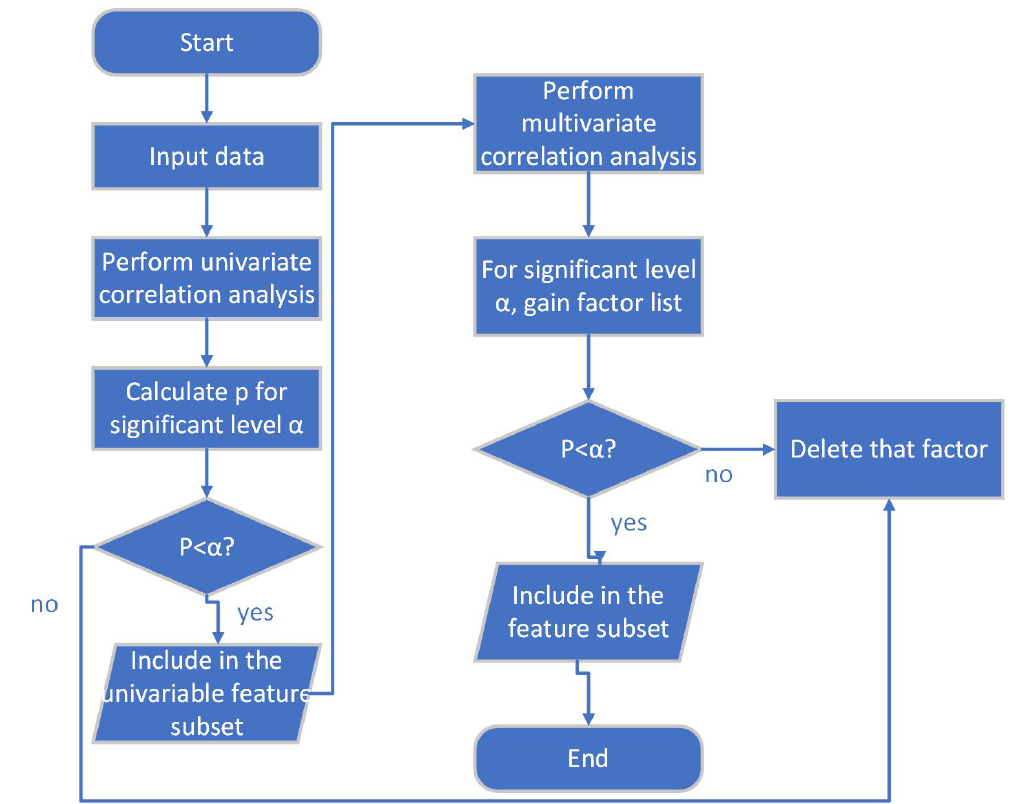
Figure 1. Flow of the feature selection